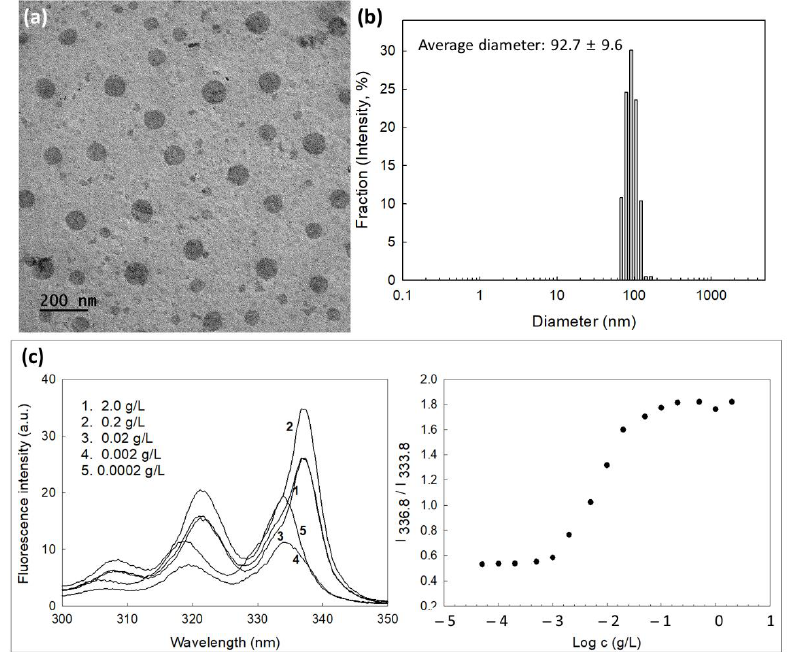
Figure 3. ( a ) Morphological observation of nanophotosensitizers of mPEGseseCe6PBAP conjugates by TEM. ( b ) Typical particle size distribution of nanophotosensitizers of mPEGseseCe6PBAP con- jugates. Average particle sizes were mean±standard deviation from five independent analysis. ( c ) Fluorescence excitation spectra of pyrene/mPEGseseCe6PBAP nanophotosensitizers in distilled wa- ter (Emission wavelength: 390.0 nm) (left) and I 336.8 /I 333.8 intensity ratio plots from pyrene excitation spectra vs. log c for mPEGseseCe6PBAP nanophotosensitizers in distilled water (right).